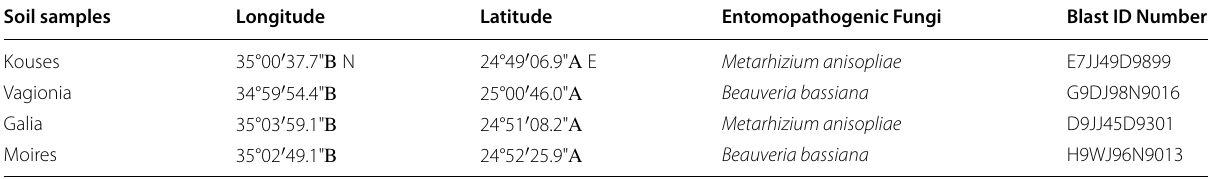
Table 1 Details of the locations from where soil samples had been collected at Crete and the entomopathogenic fungi identified per location Soil samples